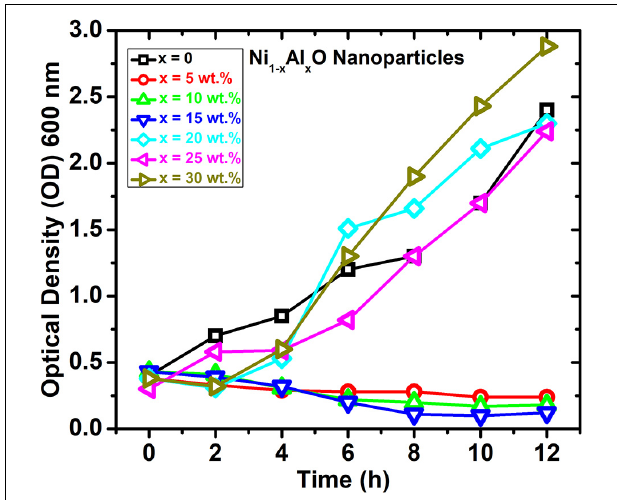
FIGURE 6 | Growth dynamics and variation of optical density of the P. aeruginosa culture in the presence of Ni 1 − x Al x O nanoparticles.